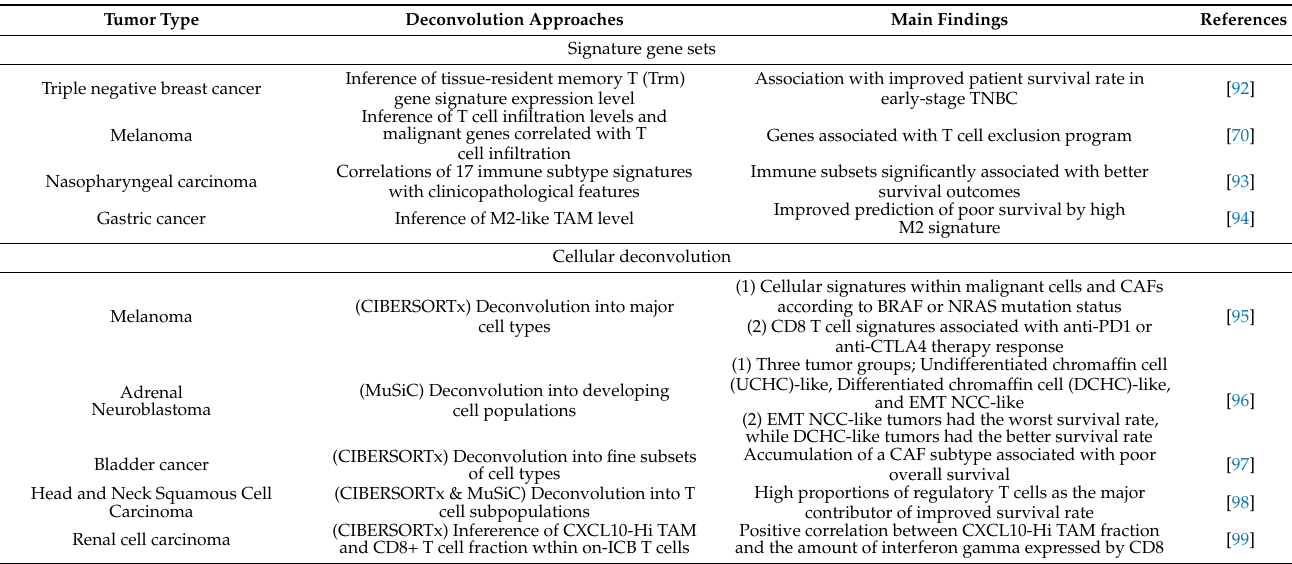
Table 5. Tumor studies using scRNA-seq data for bulk RNA-seq